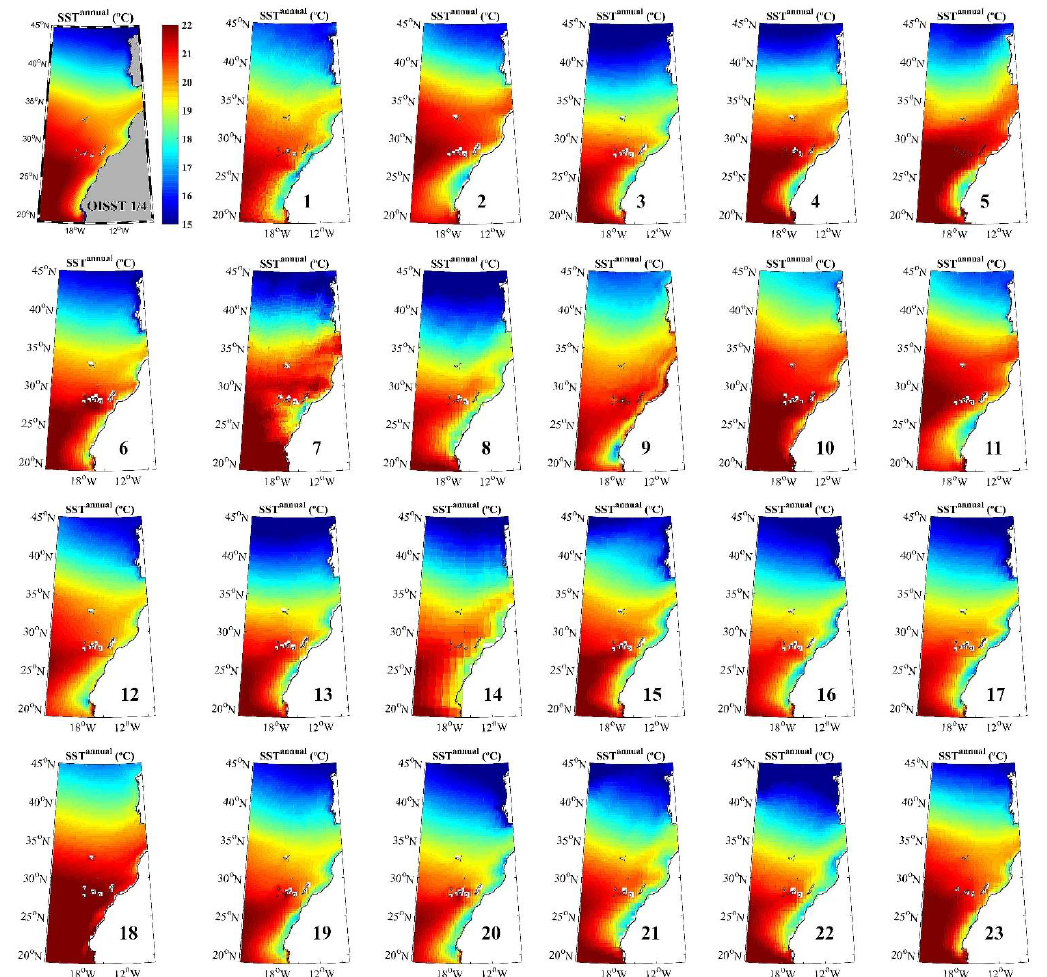
Figure 4. Mean of the annual SST (°C) for the Canary upwelling system from 1982 to 2014. The numbers of each map refer to Table 1.